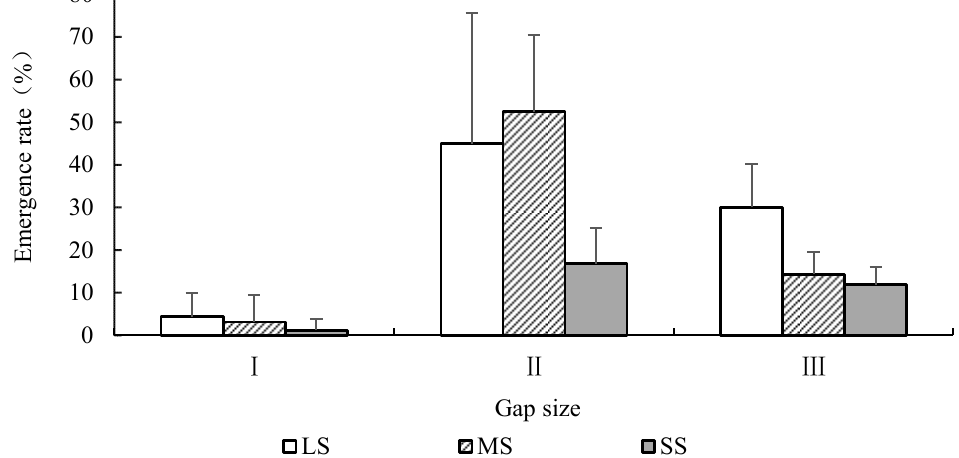
Figure 3. The emergence rate of seeds with different sizes of Quercus acutissima with the decrease of forest gap. LS: large seed; MS: medium seed; SS: Small seed.